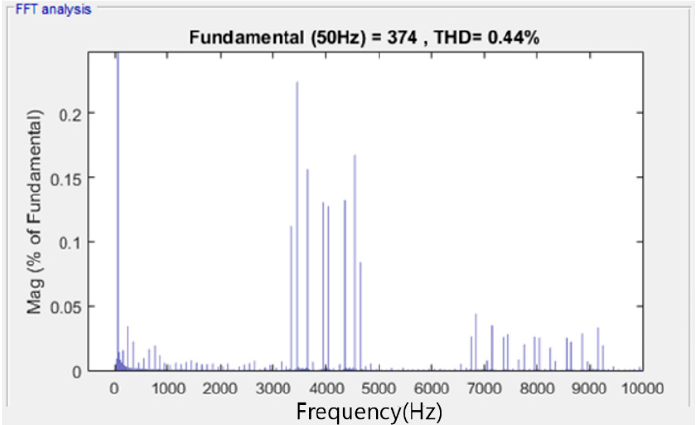
Figure 15. Three-phase four H-bridge CHB line voltage for PS PWM and equal sources.